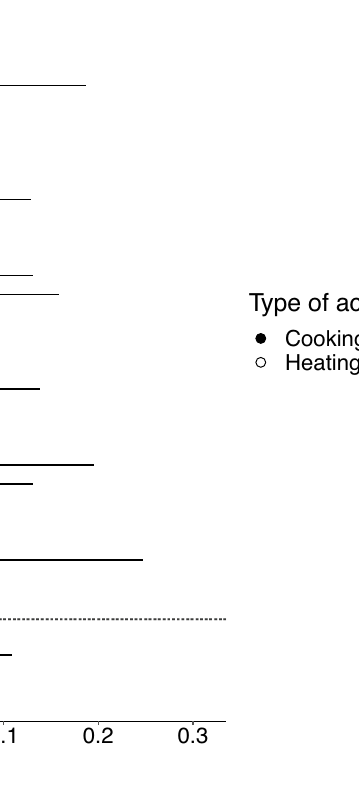
Figure 2. Associations between measures of cognitive function and current fuel use type in peri-urban northern Chinese adults. Analyses were performed based on the data of 400 participants. Results from multivariable regression models. Difference in z-score represents the difference in cognitive score associated with use of solid fuel for cooking (black circles) or heating (white circles) with exclusive use of clean fuel as reference. Data are presented as point estimates of effects (central dots of the error bar) with 95% CIs (corresponding solid lines). The vertical solid line is the reference line. The horizontal dashed line separates estimate for overall cognition from estimates for cognitive domains. For detailed estimates of univariable and multivariable regression models, please see Supplementary Table